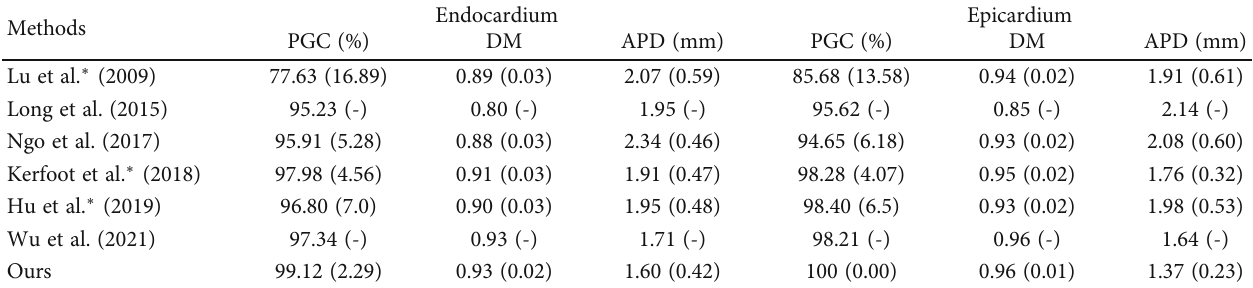
Table 2: Comparison of segmentation results on MICCAI 2009.